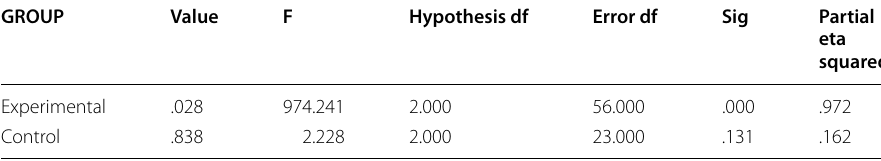
Table 4 Pairwise comparisons Measure: NGSLT